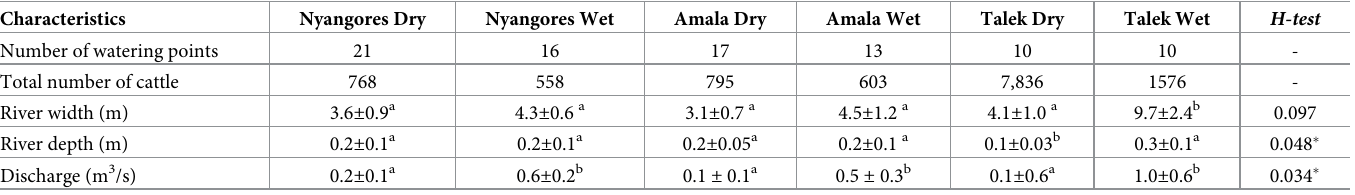
Table 1. Sizes of livestock watering points and total number of cattle that visited watering points in the Mara River basin, Kenya during the dry and wet seasons.